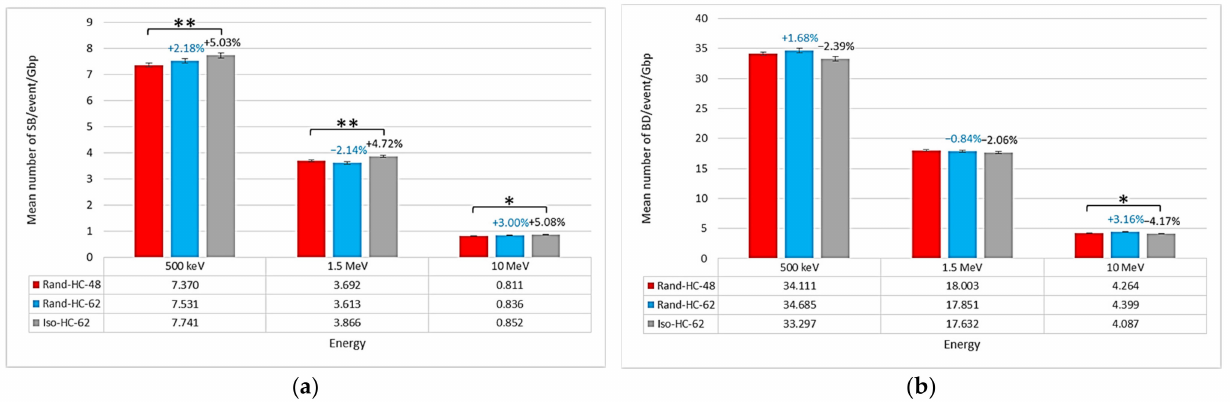
Figure 2. For the three endothelial geometries (Rand-HC-48, Rand-HC-62, and Iso-HC-62) irra- diated with protons at different energies, comparison of the mean number of ( a ) strand breaks (SBs)/event/Gbp and ( b ) base damages (BDs)/event/Gbp. For the Rand-HC-62 and Iso-HC-62 nu- clei, the figures above the bars indicate the relative increase compared to the Rand-HC-48 nucleus in mean number of ( a ) SBs/event/Gbp and ( b ) BDs/event/Gbp. Asterisks above the bars represent the degree of confidence on the difference between the two related mean values assessed by Student’s t -test (* p < 0.05, ** p <